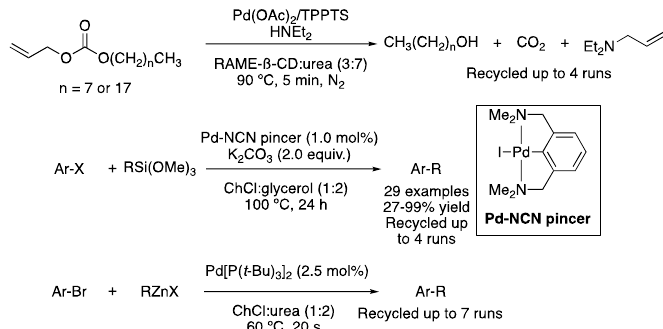
Figure 26. Tsuji-Trost, Hiyama and Negishi couplings in DESs. C-N cross-coupling reactions have also been explored in DESs as reaction media.